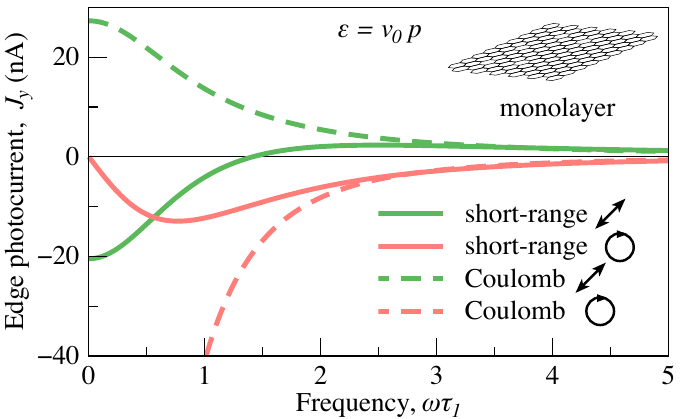
Figure 2. Frequency dependence of the edge current in 2D systems with a linear dispersion of carriers. Solid curves correspond to short-range scatterers and linearly polarized field with S 2 = E 2 (green curve) and circularly polarized field with S 3 = E 2 (red curve). Dashed curves present the results for scattering by charged impurities. The curves are calculated after Equation (23) for the parameters corresponding to single-layer graphene: v 0 = 10 8 cm/s, n = 5 × 10 11 cm − 2 (the Fermi energy E F ≈ 80 meV and the effective mass at the Fermi level m ≈ 0.013 m 0 ), τ 1 ( E F ) = 1 ps, and E = 8 V/cm corresponding to the radiation intensity I = 1 W/cm 2